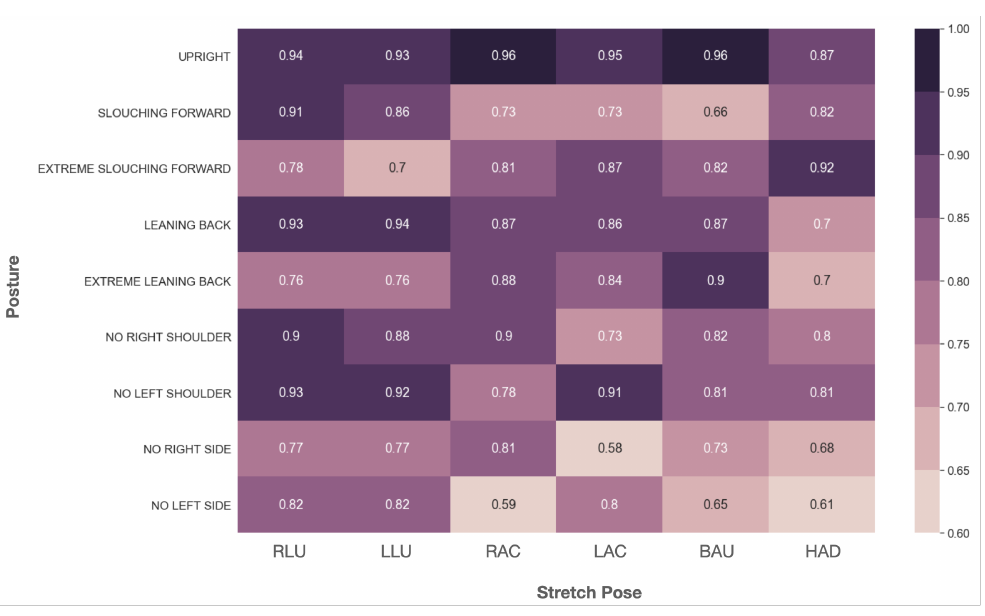
Figure 10. Cosine similarity matrix between the pressure distribution of the sitting postures and the stretch